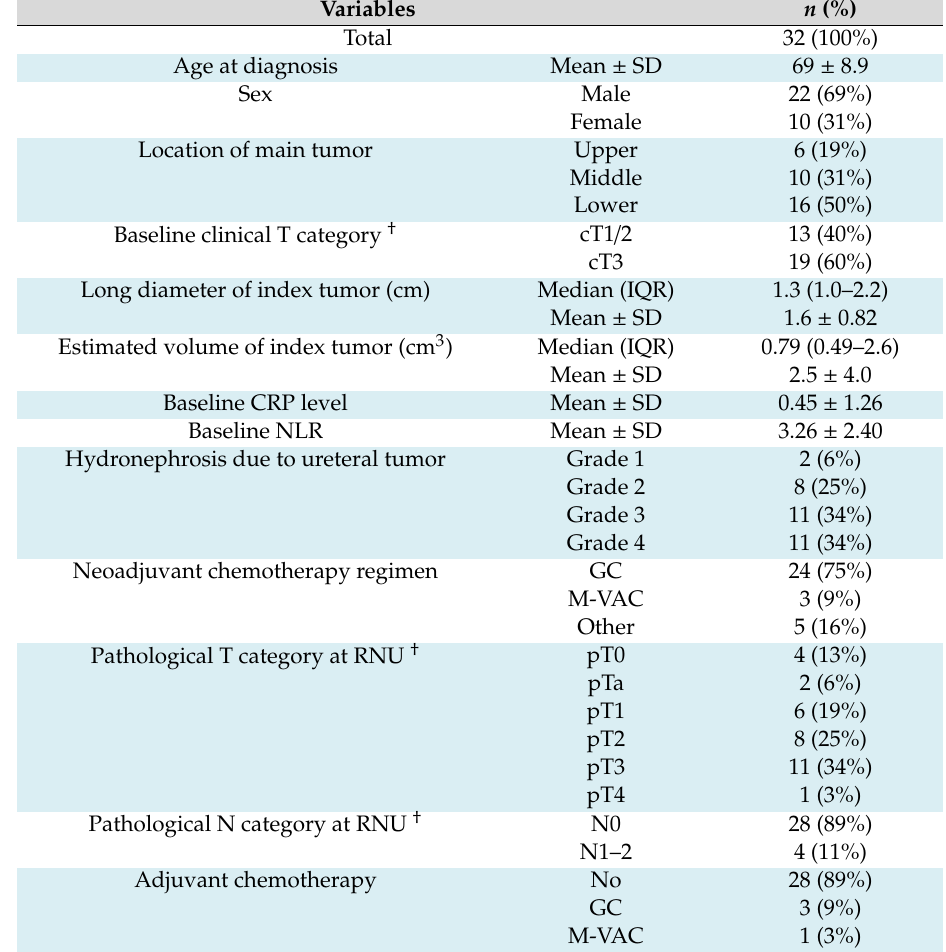
Table 1. The characteristics of patients with ureteral carcinoma undergoing neoadjuvant chemotherapy and radical